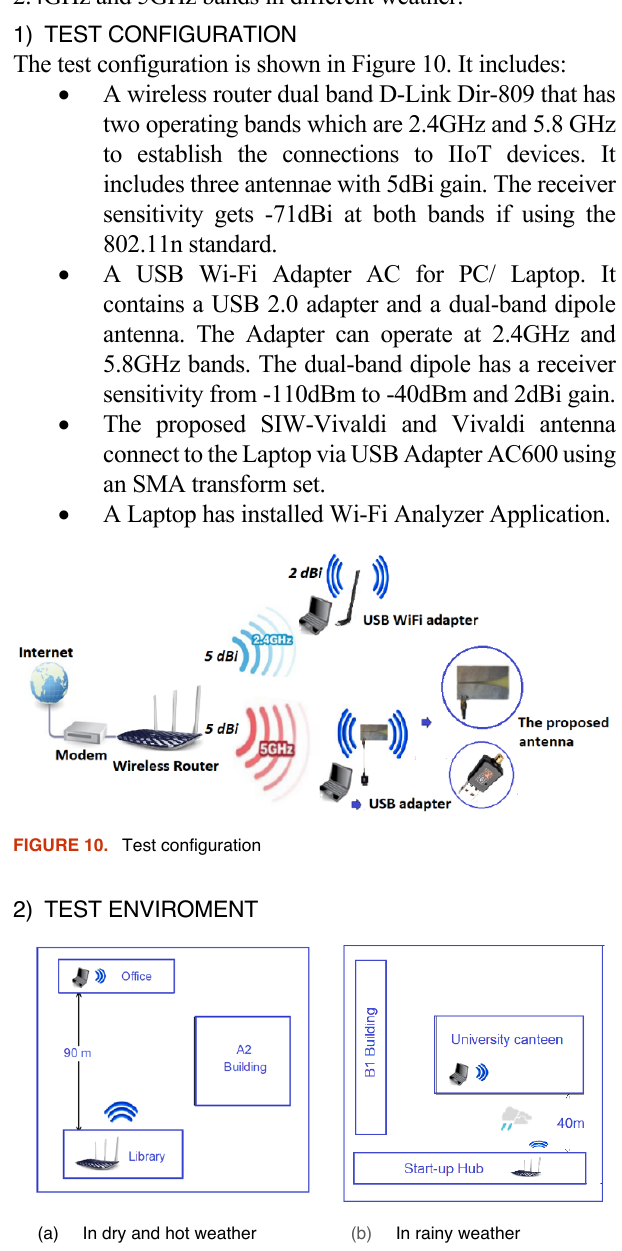
FIGURE 11. S11 Parameter of Vivaldi antenna with and without SIW